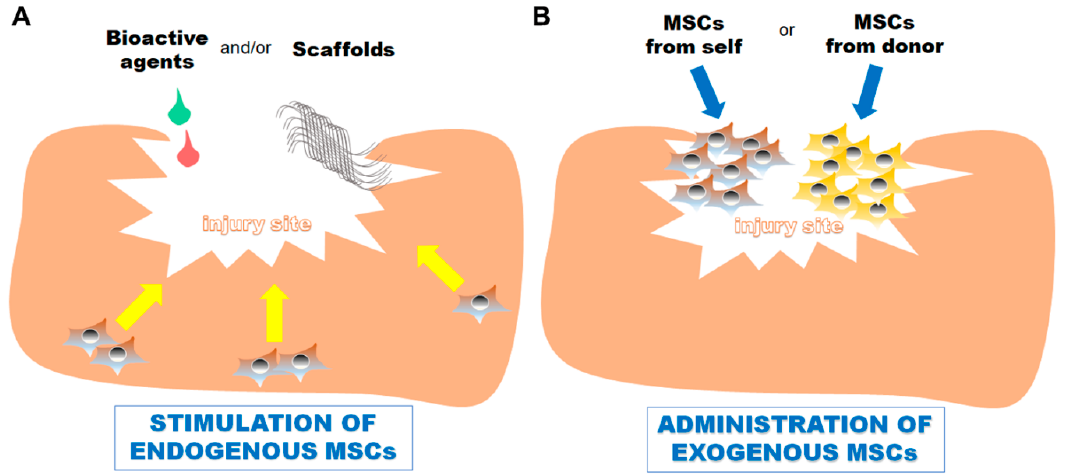
Figure 1. Conceptual diagrams of the two main approaches used to stimulate skeletal tissue healing and repair by sequestering the help of stem/progenitor cells. ( A ) Biomaterials/scaffolds and/or bioactive agents, such as growth factors, chemokines, and small molecules are placed at the site of injury to stimulate the migration and differentiation of endogenous native mesenchymal stem cells for aiding in the repair process. ( B ) Cells are physically administered exogenously, from one anatomical location of the patient to the site of injury, or from a donor, to aid in the repair process. This can be done with or without a scaffold or biomaterial to hold the newly administered cells in